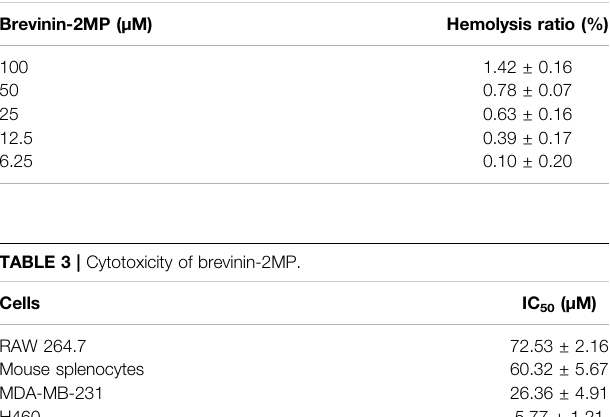
TABLE 2 | Hemolytic activity of brevinin-2MP. Brevinin-2MP ( μ M)